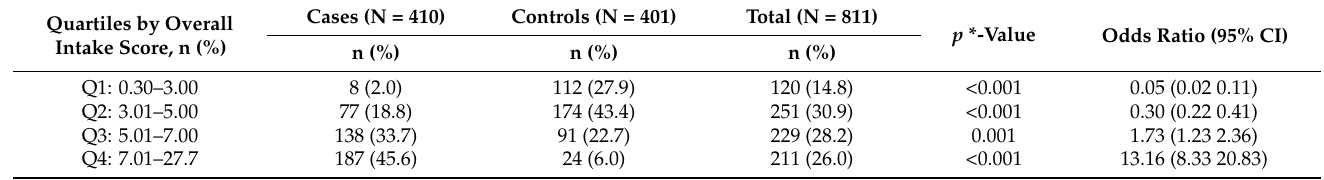
Table 4. Comparison by quartiles of overall intake in cases versus